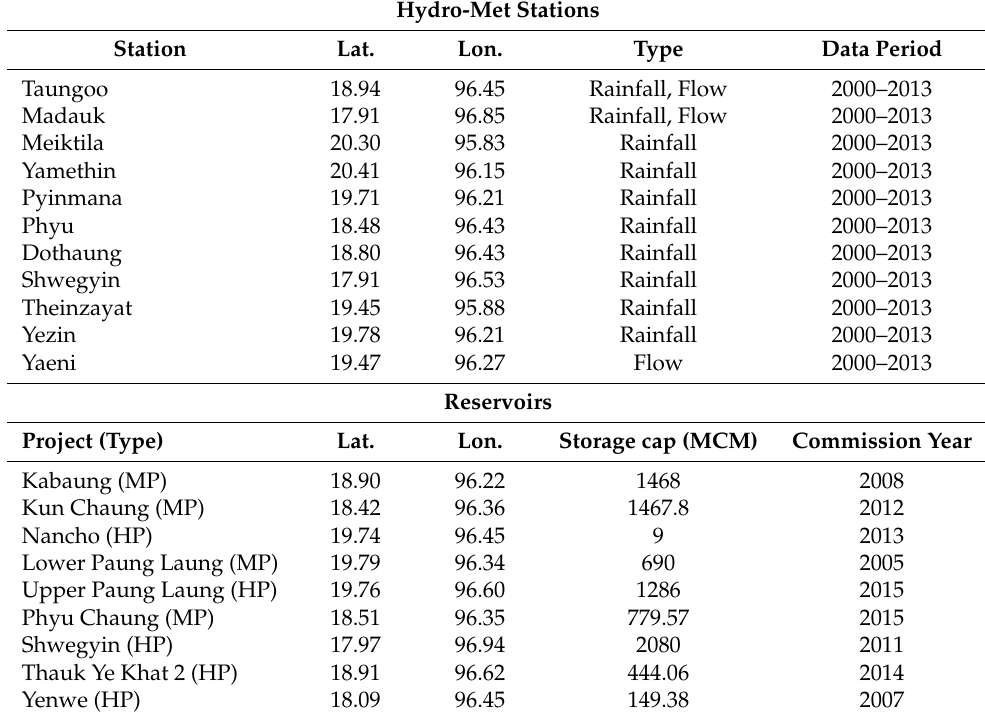
Table 2. Location of hydro-met stations and reservoirs used in the SRB.